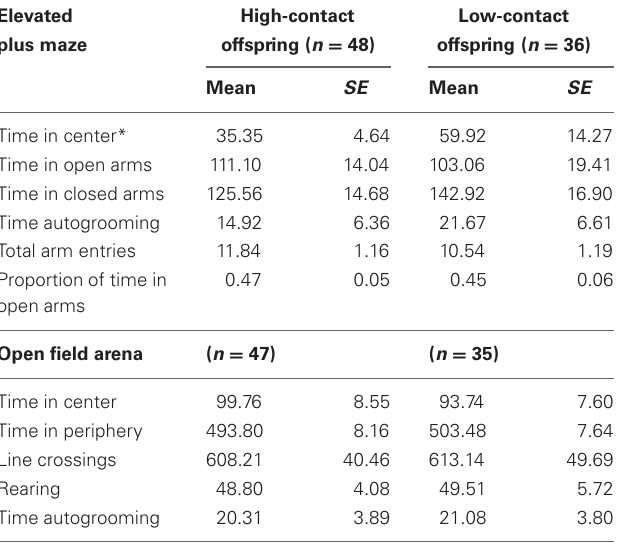
Table 2 | Data from anxiety-like behavior measures.